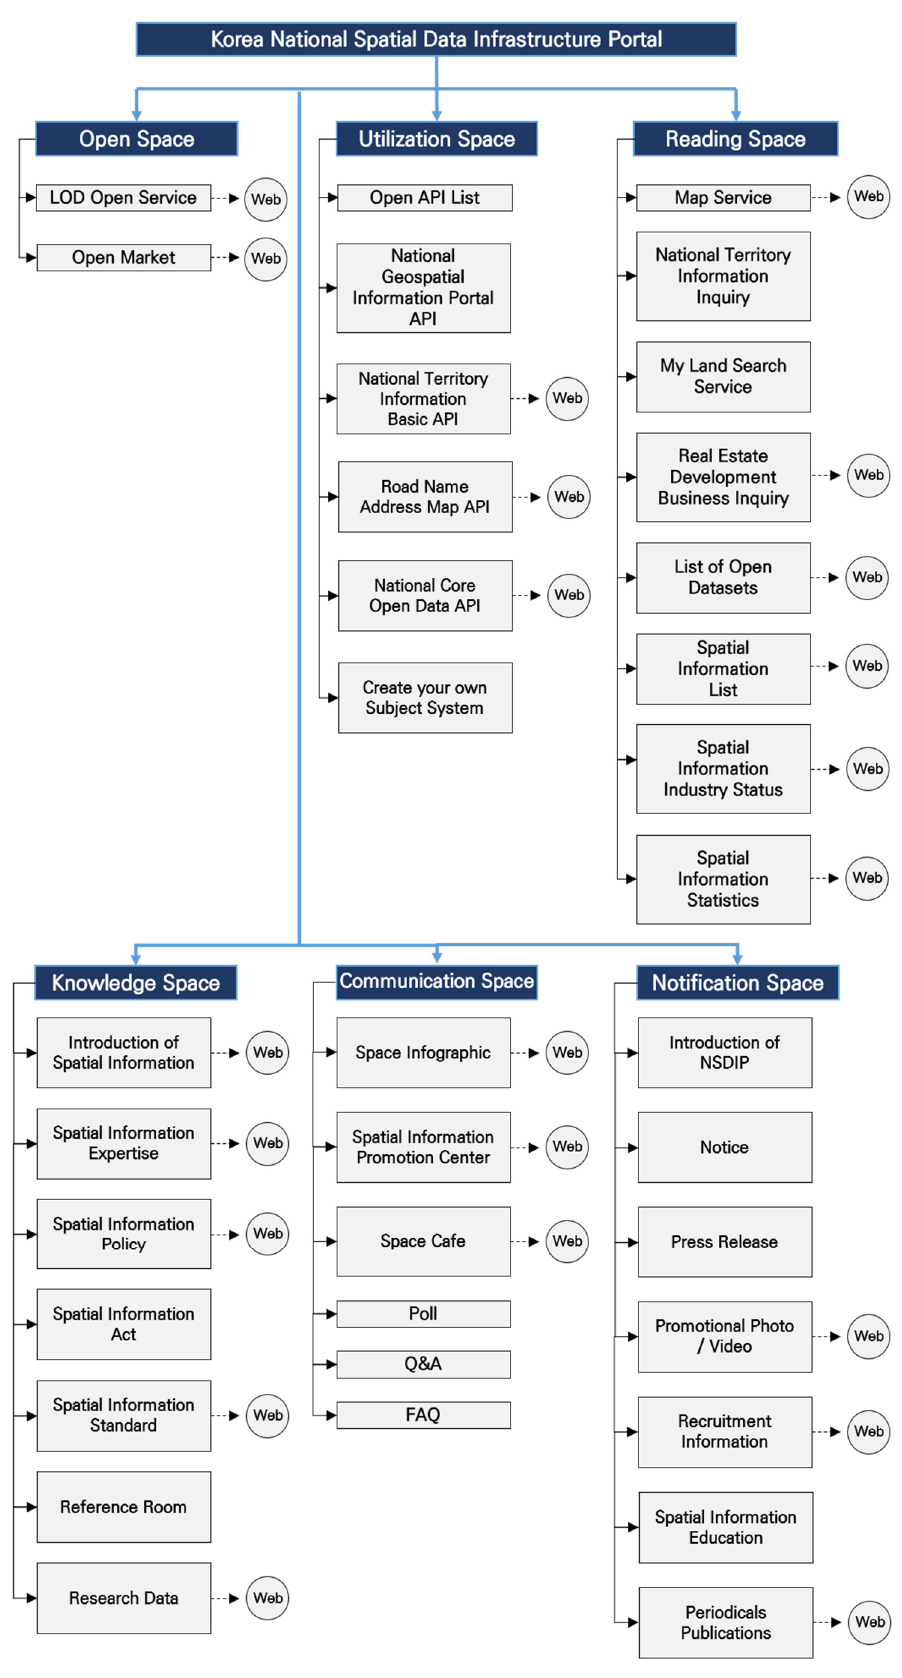
Figure 4. Content diagram of NSDIP.